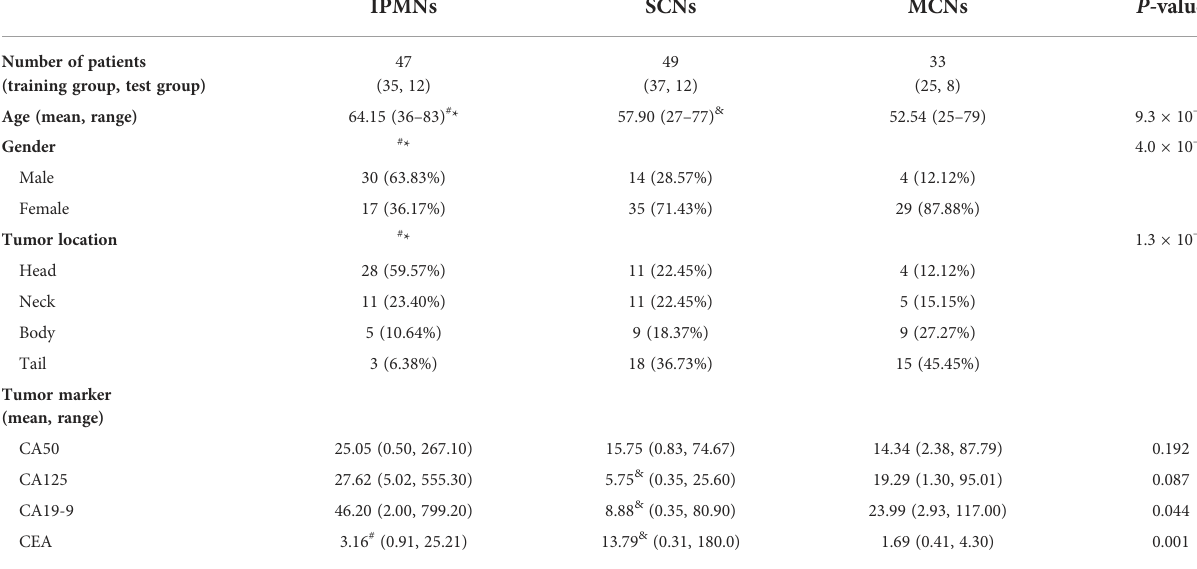
TABLE 1 Characteristics of patients with IPMNs, SCNs, and MCNs. IPMNs SCNs MCNs P -value